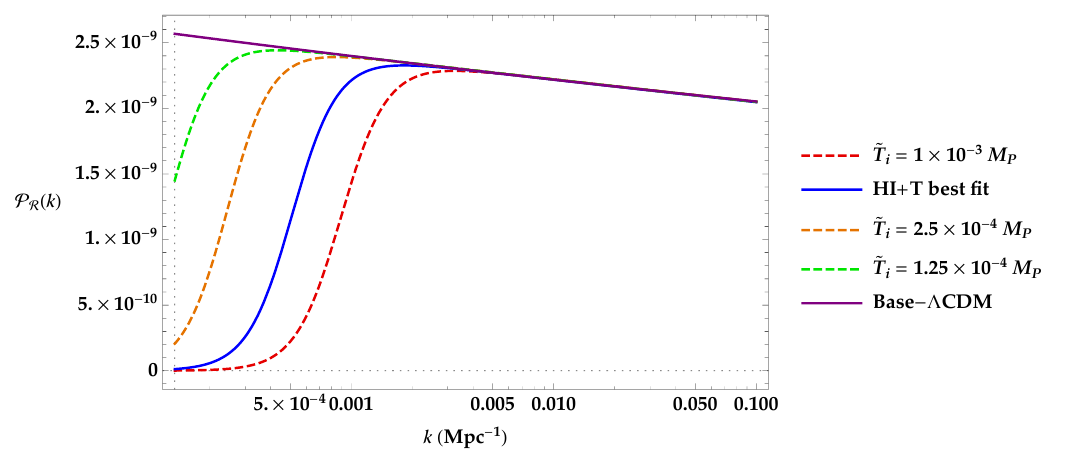
Figure 2 . The primordial curvature power spectra P R ( k ) for various initial temperatures e T i . The standard power-law spectrum of the base-(cid:3)CDM model, P R ( k ) / k n s (cid:0) 1 , is given by the purple solid curve. The blue solid curve depicts the best-(cid:12)t prediction of the Higgs in(cid:13)ation with an initial temperature e T i = 5 : 15 (cid:2) 10 (cid:0) 4 M P (or 3 : 62 (cid:2) 10 (cid:0) 3 M P ).